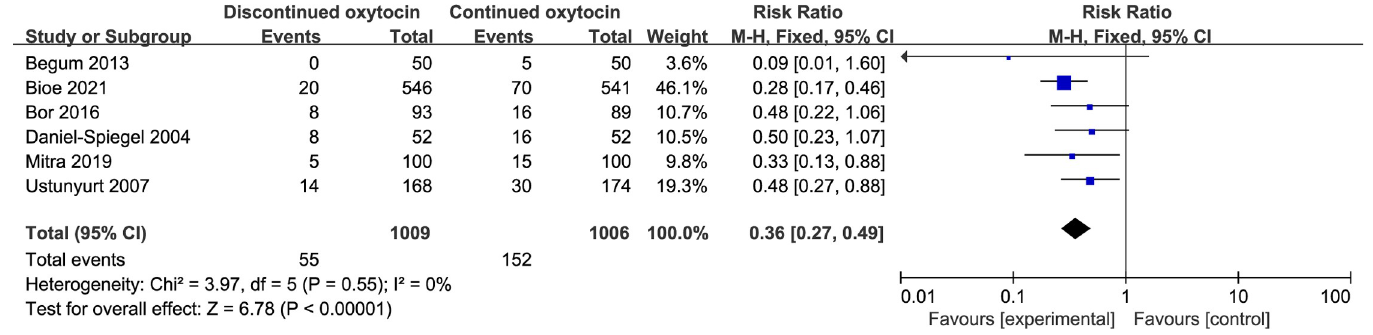
Fig 7. Pooled results for each outcome.